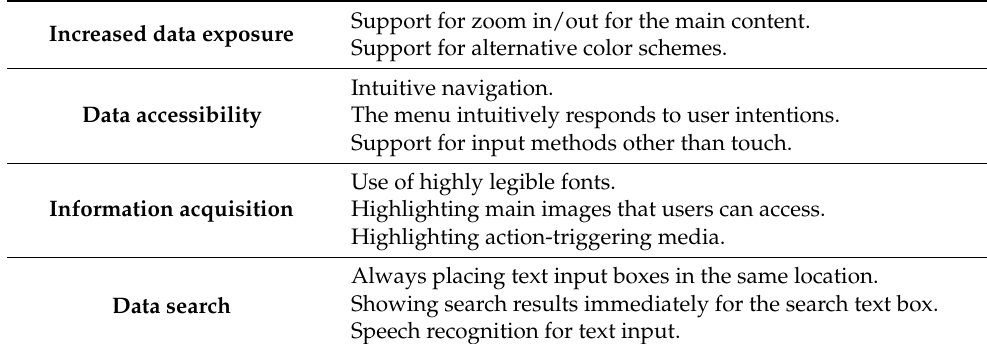
Table 1. UXDG (user experience design guidelines) for the visually impaired [24]. Increased data exposure